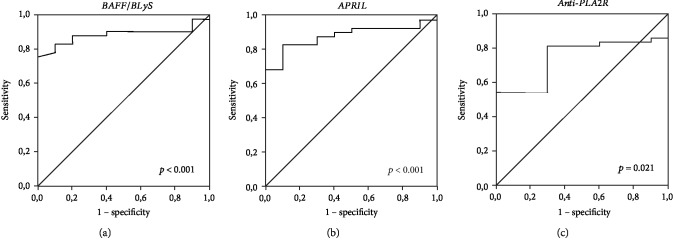
ROC curves for BAFF, APRIL, and anti-PLA2R serum levels and 24-month clinical outcome. (a) ROC curve analysis to validate the association of BAFF/BLyS serum levels at baseline with the probability to obtain CR/PR after 24-month follow-up (AUC = 0.884, CI 95% 0.792-0.976, p < 0.001). (b) ROC curve analysis to validate the association of APRIL serum levels at baseline with the probability to obtain CR/PR after 24-month follow-up (AUC = 0.880, CI 95% 0.786-0.975, p < 0.001). (c) ROC curve analysis to validate the association of anti-PLA2R serum levels at baseline with the probability to obtain CR/PR after 24-month follow-up (AUC = 0.737, CI 95% 0.598-0.875, p = 0.021).